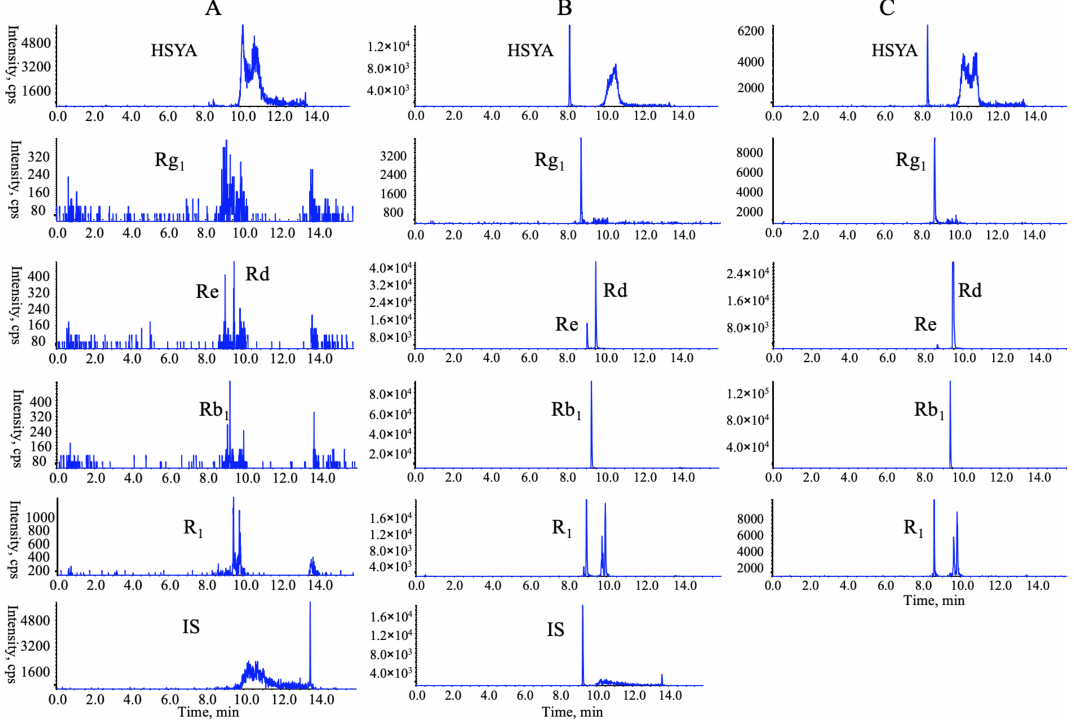
Figure 3. Representative multiple reaction monitoring (MRM) chromatograms of target analytes in rat plasma in a positive mode: ( A ) blank plasma; ( B ) blank plasma spiked with six chemical standards and internal standards (IS); ( C ) plasma sample collected at 2 h following oral administration of extract CNP ( Carthamus tinctorius extract (CTE) 50 mg / kg + notoginseng total saponins (NGTS) 60 mg / kg) to